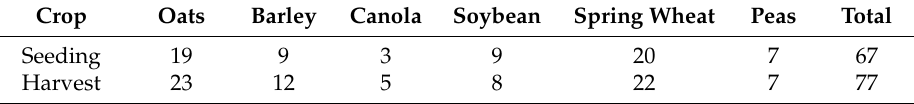
Table 1. Number of fields observed for 2019 growing season (n =